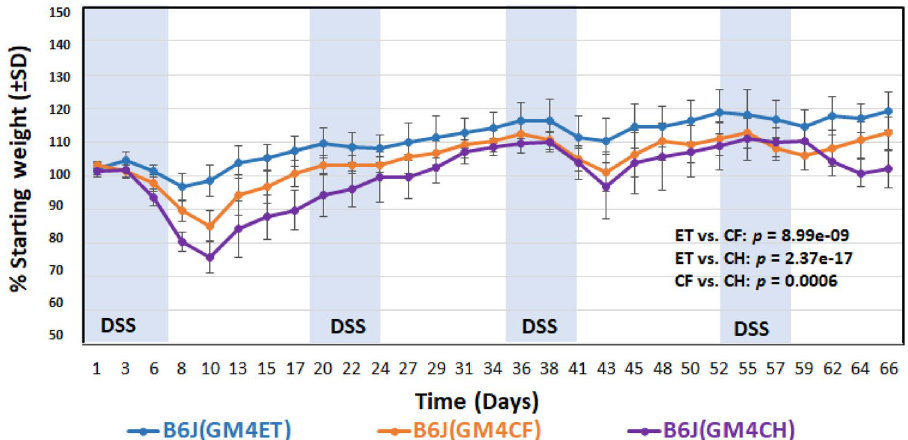
Figure 5. Influence of transfer method on susceptibility to DSS-induced colitis when transferring high-richness GM4 to B6J mice . Comparison of DSS-induced weight change between B6J mice that were recipients of GM4 using ET, CF, and CH transfer methods. Statistical analysis revealed a significant difference between transfer methods (ET vs. CH: p = 2.37e-17; ET vs. CF: p = 8.99e-09; CF vs. CH: p = 0.0006). There were significant effects of time ( p = 2.99e-41), DSS treatment ( p = 2.04e-19), and an interaction of time and DSS treatment ( p = 5.60e- 05). However, there was no significant effect of sex ( p = 0.755); as a result, the figure shows data from both sexes. The longitudinal measurements of each mouse were considered. A random intercept mixed effect model with AR covariance structure was performed for statistical